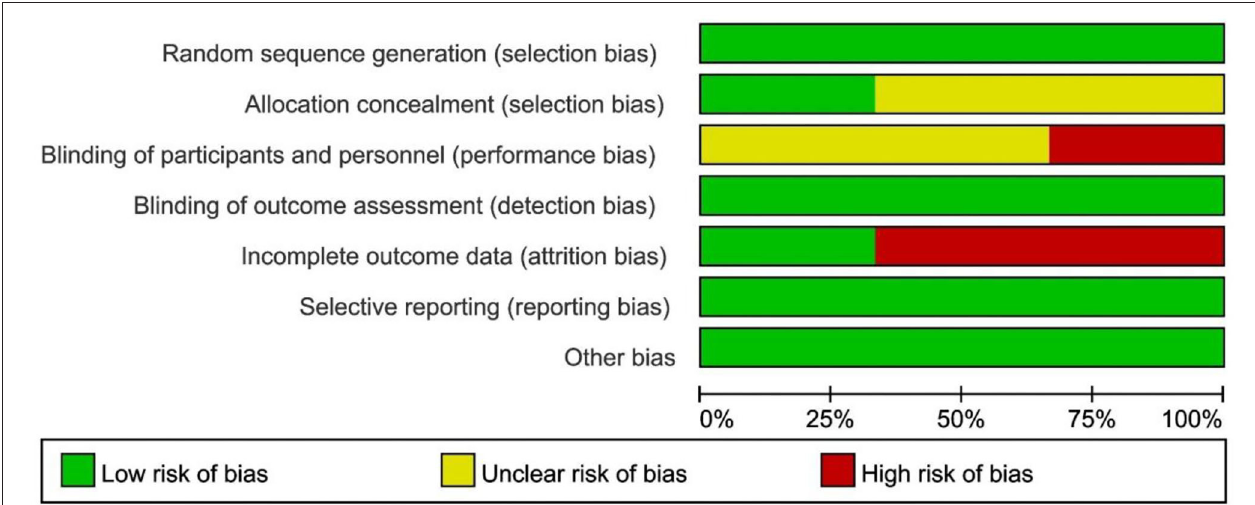
FIGURE 2 | Risk of bias graph review authors’ judgments about each risk of bias item presented as percentages across all included RCT.